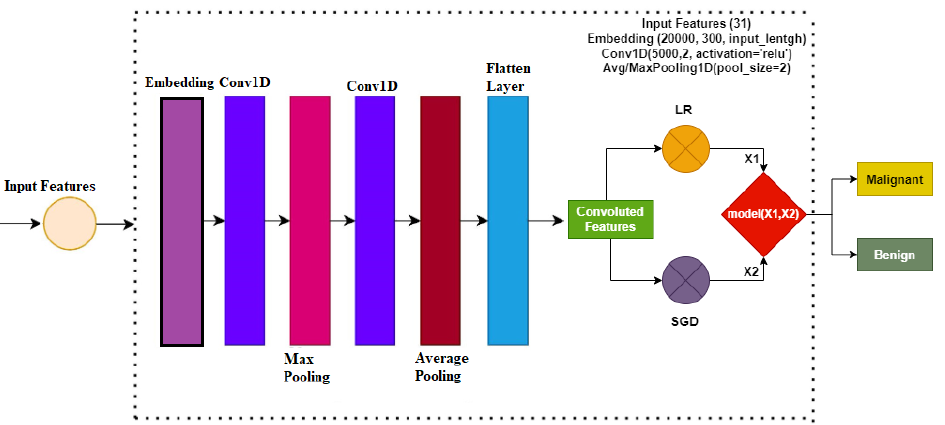
Figure 2. Proposed methodology architecture